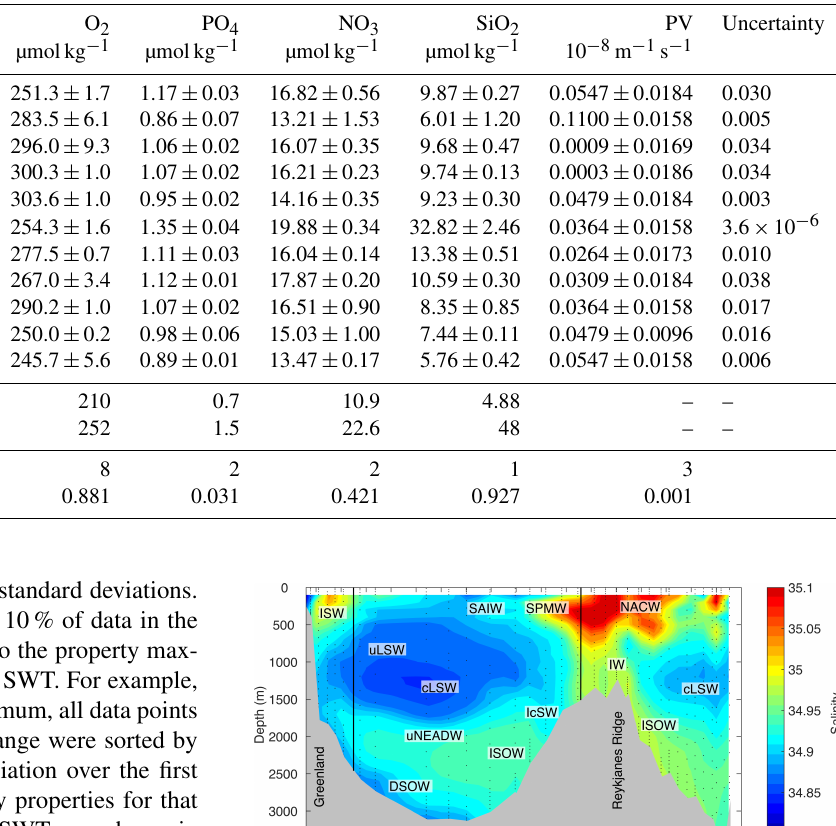
Table 2. Source water type (SWT) parameters and their standard deviation used for the eOMP analysis for Subarctic Intermediate Wa- ter (SAIW), Intermediate Water (IW), classical and upper Labrador Sea Water (cLSW and uLSW), Denmark Strait Overflow Water (DSOW), upper North-east Atlantic Deep Water (uNEADW), Iceland–Scotland Overflow Water (ISOW), Icelandic Slope Water (IcSW), Irminger Sea Water (ISW), Subpolar Mode Water (SPMW) and North Atlantic Central Water (NACW). Definitions for Mediterranean Water (MW) and lower North-east Atlantic Deep Water (lNEADW) ( ∗ ) from García-Ibáñez et al. (2015) are used only for the composite analysis but not in the eOMP. The weights for the equations are given. The mass weight is 150. The mean parameter residual is given (error). The last column gives an uncertainty estimate (per one) for the SWT contribution based on a Monte Carlo simulation.